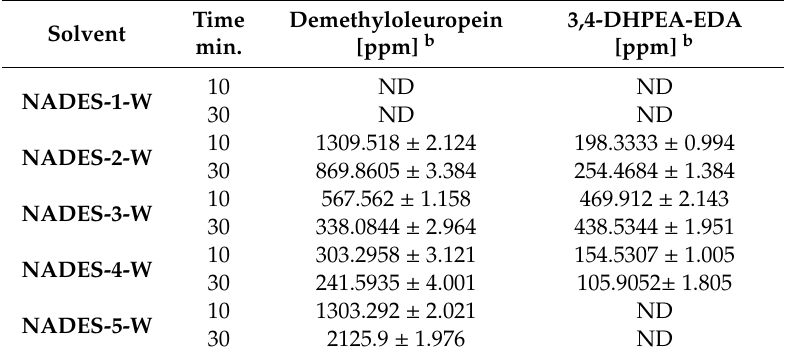
Table 5. Content of phenolic compounds extracted in the ripe olives (in NADES added with 20% water) from HPLC analysis a . Time Solvent